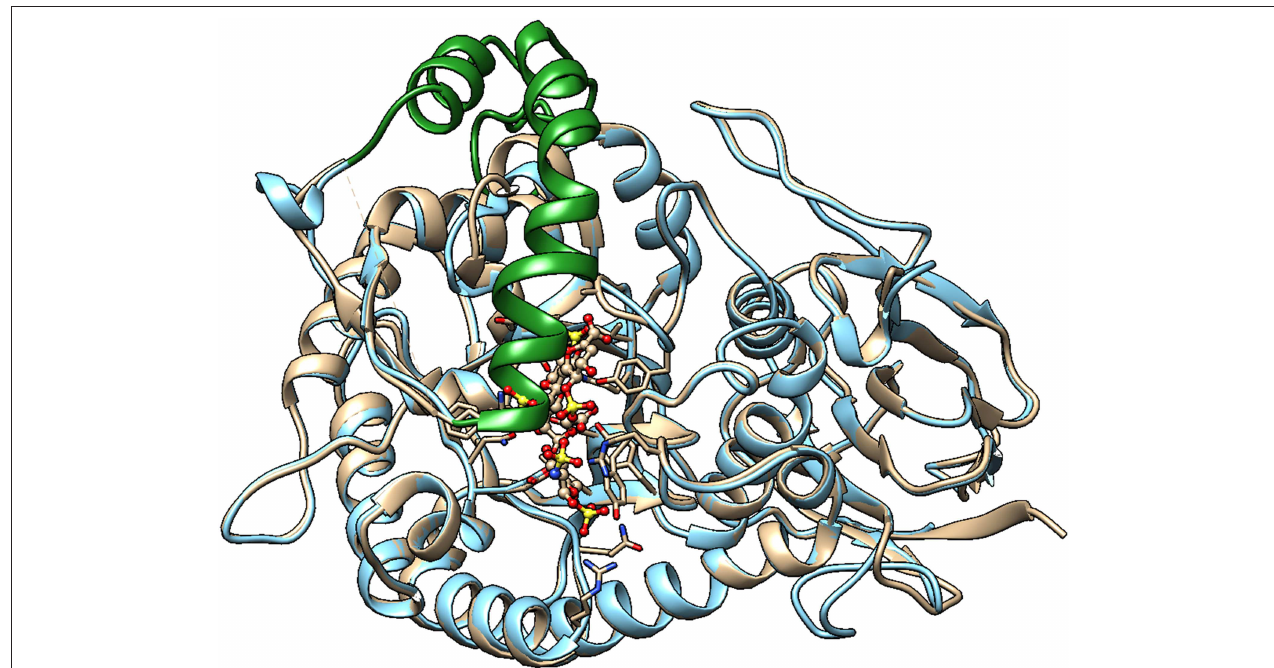
FIGURE 3 | Homology model of Hpa2 was built using the SWISS-MODEL server. PDB 5LA4 (Proheparanase) was used as a template. The obtained homology model of Hpa2 was then superimposed onto active heparanase (PDB code: 5e9c) cocrystal with heparin tetrasaccharide substrate. The linker (green ribbon) of Hpa2 partially occupies the heparin binding site. This is also true for proheparanase (PDB code:5LA4 structure). Heparanase is shown in golden, and Hpa2 in blue.